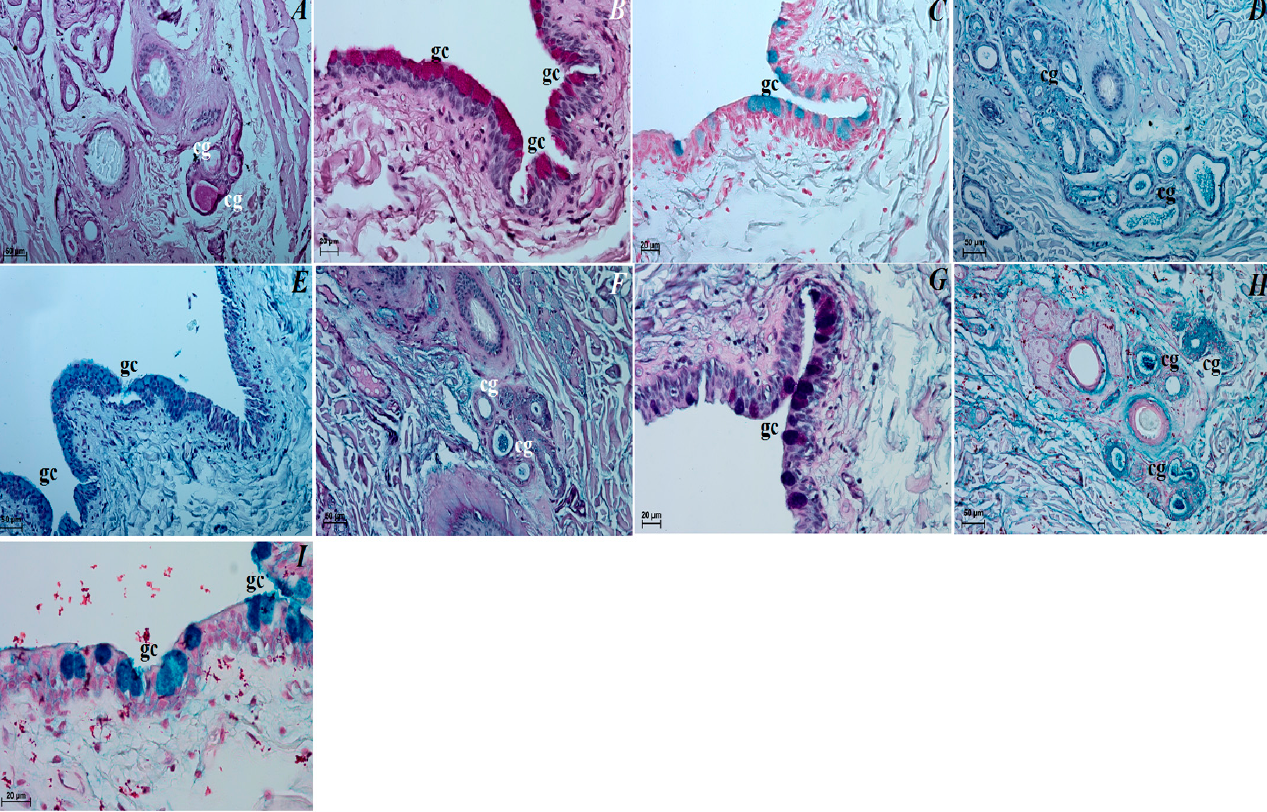
Figure 9. Histochemical photomicrograph of the Ursus thibetanus upper and lower eyelids. ( A ) = PAS slightly ( − /+) positive reaction in the ciliary glands (cg); ( B ) = PAS strongly (+++) positive reac- tion in the goblet cells (gc); ( C ) = AB pH 1.0 strongly (+++) positive reaction in the goblet cells; ( D ) = AB pH 2.5 slightly ( − /+) positive reaction in ciliary glands; ( E ) = AB pH 2.5 strongly (+++) positive reaction in the goblet cells; ( F ) = AB pH 2.5/PAS slightly ( − /+, blue color—acidic sulfated mucosubstances and sialomucins) positive reaction in the ciliary glands; ( G ) = AB pH 2.5/PAS strongly (+++, magenta color—neutral mucins) positive reaction in the goblet cells; ( H ) = HDI slightly ( − /+) positive reaction in the ciliary glands; ( I ) = HDI strongly (+++) positive reaction in the goblet cells. Scale bars: ( A , D – F , H ) = 50 µ m; ( B , C , G , I ) = 100 µ m. The superficial gland of the third eyelid. The serous acinar cells showed a PAS and AB pH 2.5 weakly ( − /+) reaction, AB pH 1.0 and HDI negative ( − ) reaction, while AB pH 2.5/PAS (blue color) weakly (+) positive reaction. For mucous acinar cells of these gland, PAS, HDI and AB pH 2.5/PAS (magenta color) middle positive (++) reaction, and AB pH 2.5 slightly ( − /+) positive reaction were found (Figure 6F–J, see Table 1). The AB pH 1.0 stain in these mucous acini was a negative reaction (see Table